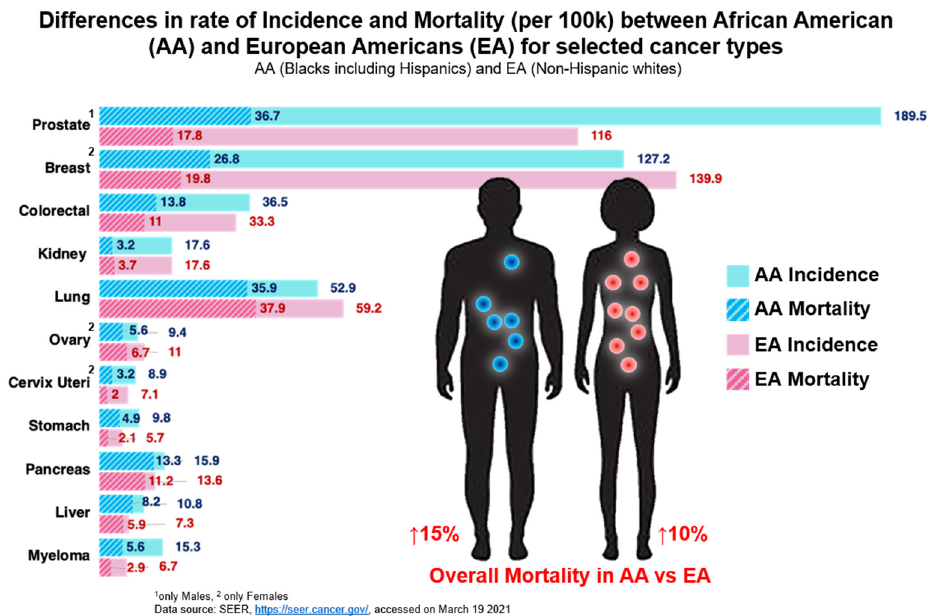
Figure 1. Differences in rate of incidence and mortality between African Americans and European Americans for selected cancer types.